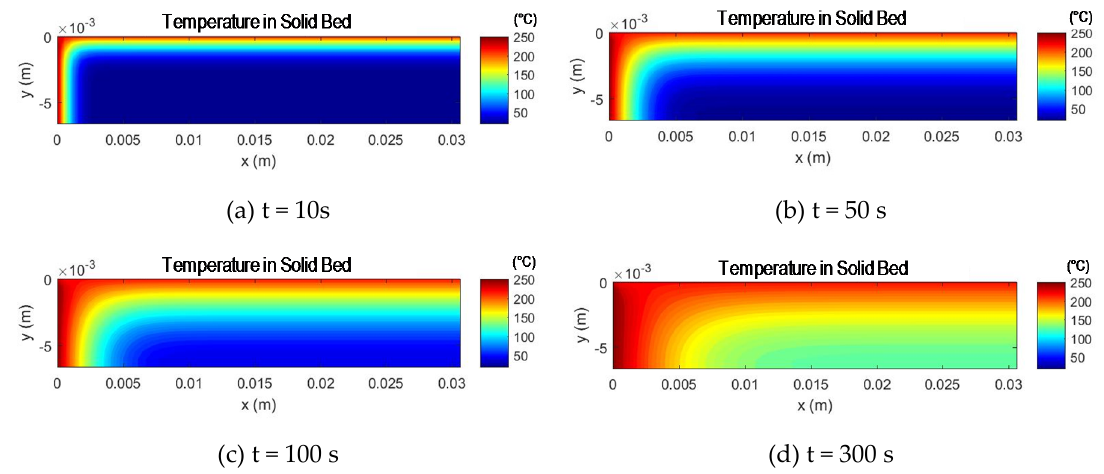
Figure 13. Temperature of solid bed at D = 45 mm extruder metering section at different residence times ( a – d ). Width = 30 mm, height = 6 mm, T start = 20 °C, T melt = 250 °C, T film = 220°C, material: PP RD204CF.